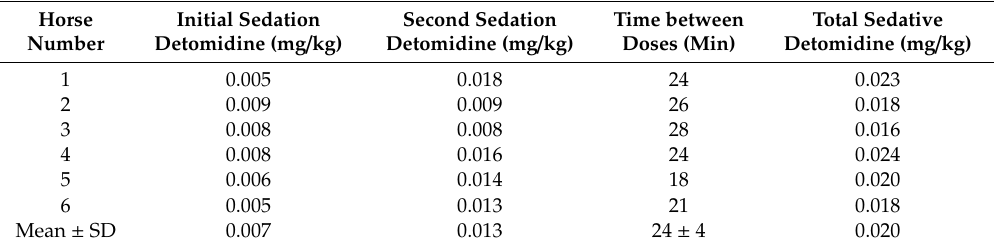
Table 1. Summary of sedation protocol. Doses of IV detomidine hydrochloride given at the initial sedation (for placement of the IV catheter) and at the second sedation (for lifting procedure) were chosen according to the level of excitement due to environmental stimuli and horse’s demeanor.